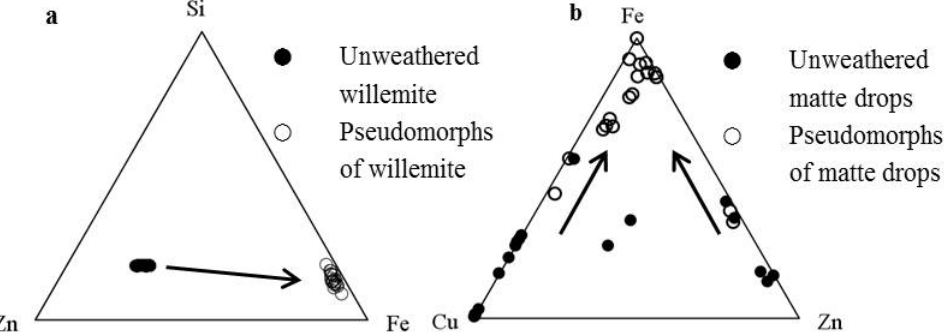
Figure 8. Ternary diagrams of ( a ) Si-Zn-Fe concentrations of unweathered and pseudomorphs of willemite and ( b ) Fe-Cu-Zn concentrations of unweathered and pseudomorphs of matte